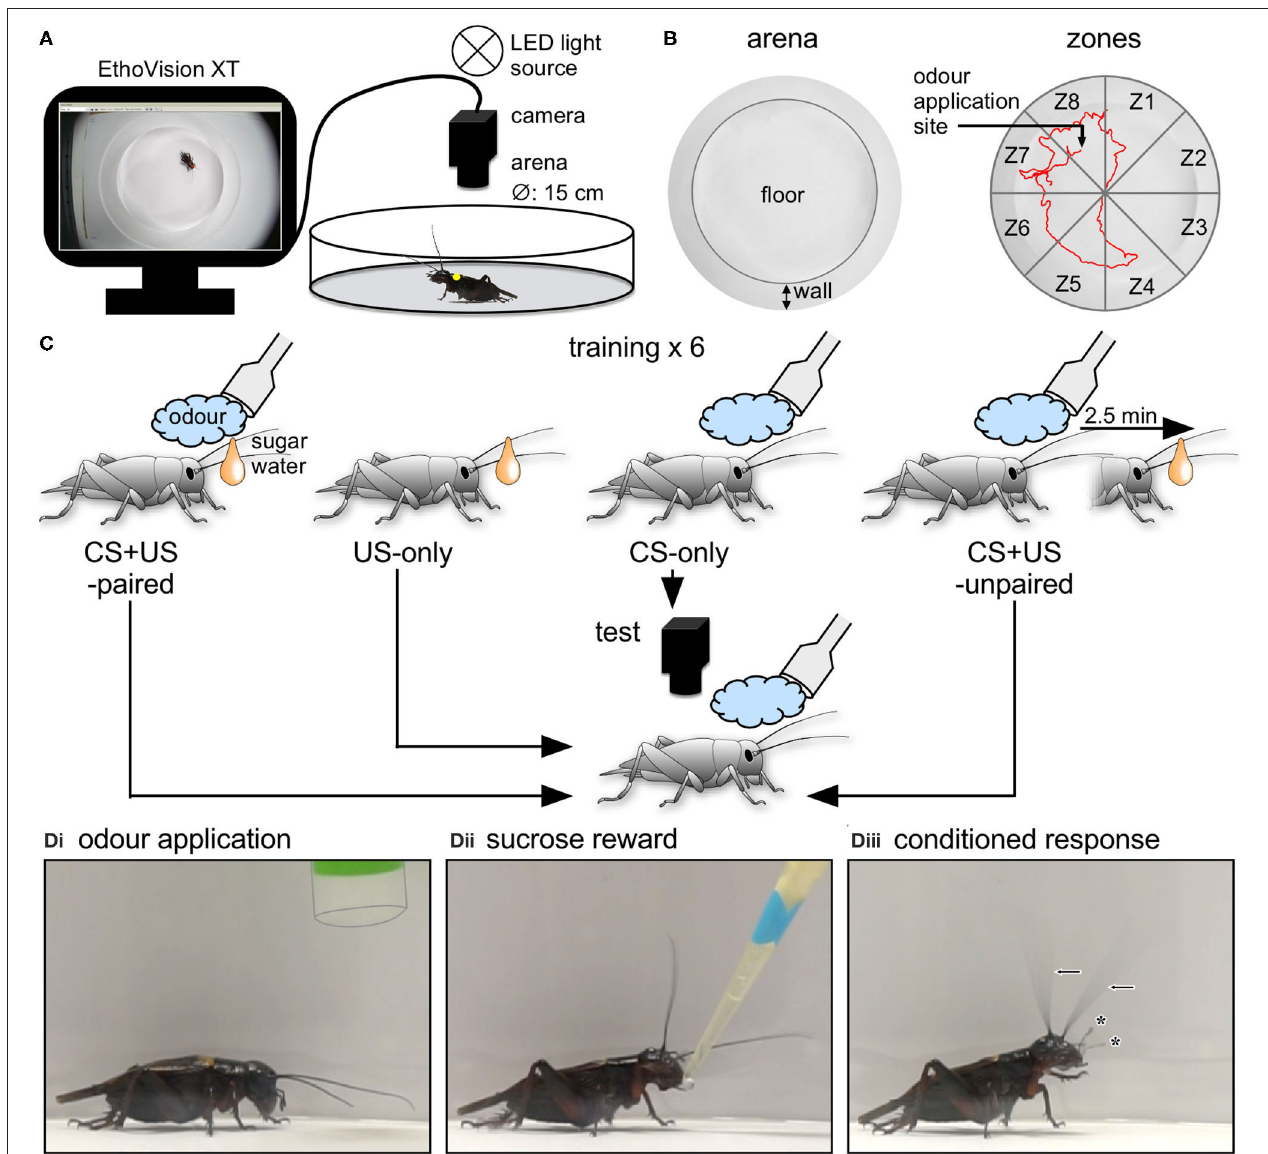
FIGURE 1 | Experimental procedure. (A) Video-tracking setup. After marking, each cricket was placed in a circular arena and its motor response to a stimulus was filmed and digitally tracked using a digital video camera connected to personal computer running tracking software (EthoVision XT) for storage and analysis. (B) Left side: Top view of the arena showing the floor and side. Right side: Top view of the arena showing the eight virtually partitioned zones (Z1–Z8), used also for defining the stimulus site. The red line shows an exemplary 2min track of an animal’s movements in the arena. (C) Single odour conditioning paradigm employed to create two binary responding groups (US-only and CS + US-paired) used to build and test the model and two external control groups (CS-only; CS + US-unpaired). Individual crickets were trained (6 x ; inter-training-interval = 5min) and were either given odour alone (CS-only, blue cloud), fed on sugar water (US-only, orange drop) or rewarded with a sugar water droplet directly after the presentation of the odour (CS + US-paired). CS + US-unpaired animals were presented with odour and reward with an interposing pause of 2.5min. After 30min the crickets were presented with the odour and simultaneously tracked with the video-tracking software for 2min. (D) Photos showing examples of a cricket’s responses to the initial application of an odour (pipette outlined), (Di) subsequent reward during training (Dii) and the conditioned odour response at the recall test, 30min after training. (Diii) Note elevated head, waving antennae (arrows) and extended palps